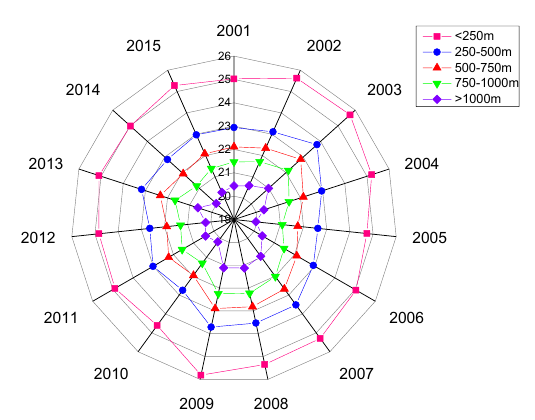
Figure 7. Radar map of LST change with the coverage different In order to quantitative analysis the influence of altitude on LST, the altitude is divided into five levels by natural break point classification: below 250m is the first level, 250-500m is second, Figure 5.Seasonal average temperature and annual average LST 500-750m is third, 750-1000m is fourth, and above 1000m is the change from 2001 to 2015 of Fujian fifth(fig 6). From the different levels of altitude, we can see that with the increase of altitude from first level to fifth, the temperature is continue decreasing. However, the decreasing trend in first level to second is different from others two adjacent levels. When the altitude is increasing from first level to second, the temperature is decreasing 2 C, but when the altitude is greater than second level, with the altitude going on to the next level the temperature is decreasing about 1. C, about.1/2 times decreasing